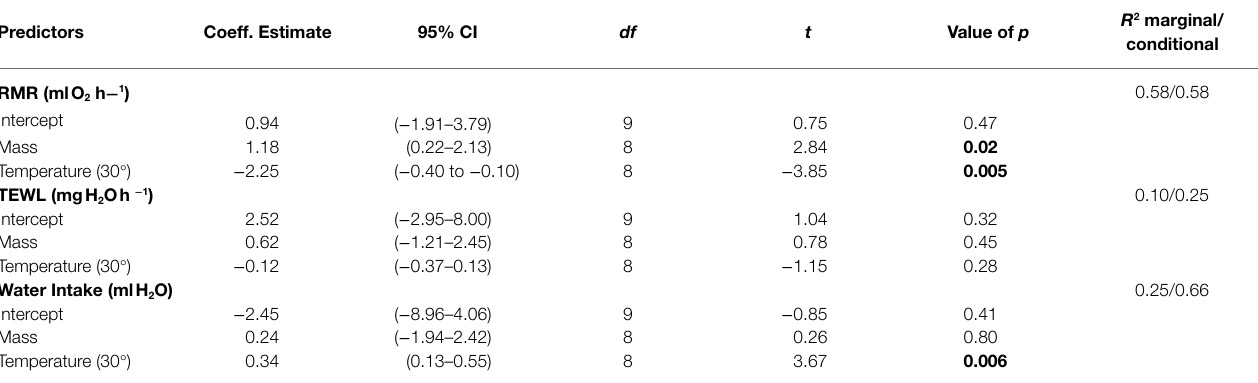
TABLE 1 | Results of generalized linear mixed model testing the effect of 15 days of thermal acclimation to 15 ° C (cold) and 30 ° C (warm) on resting metabolic rate (RMR), total evaporative water loss (TEWL), and water intake in Zonotrichia capensis. Predictors